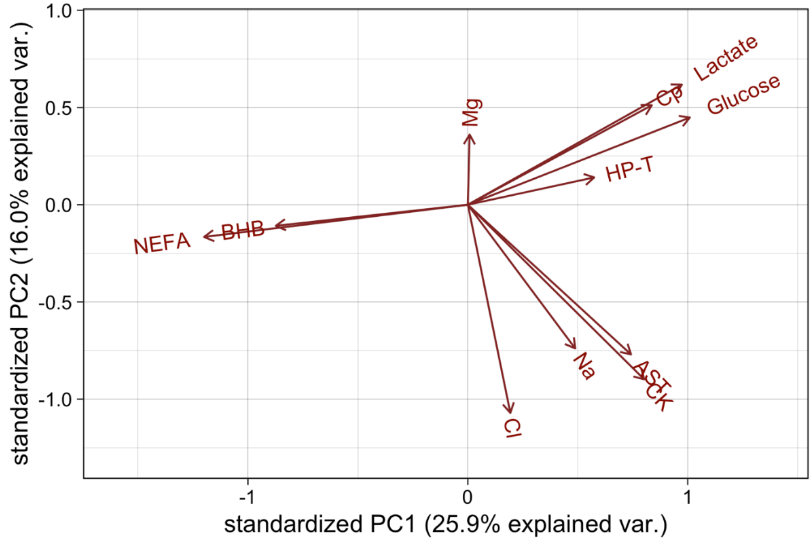
Figure 3. Loadings of each variable on the first and second principal components. NEFA (non-esterified fatty acids), BHB ( β -hydroxybutyrate), Mg (magnesium), Cp (ceruloplasmin), HP-T (haptoglobin), AST (aspartate transaminase), CK (creatine kinase), Na (sodium), Cl (chloride) Table 6. Correlation coe ffi cients for blood and muscle metabolites and ultimate pH. Bolded correlations indicate significance at p < 0.05 and r 2 >